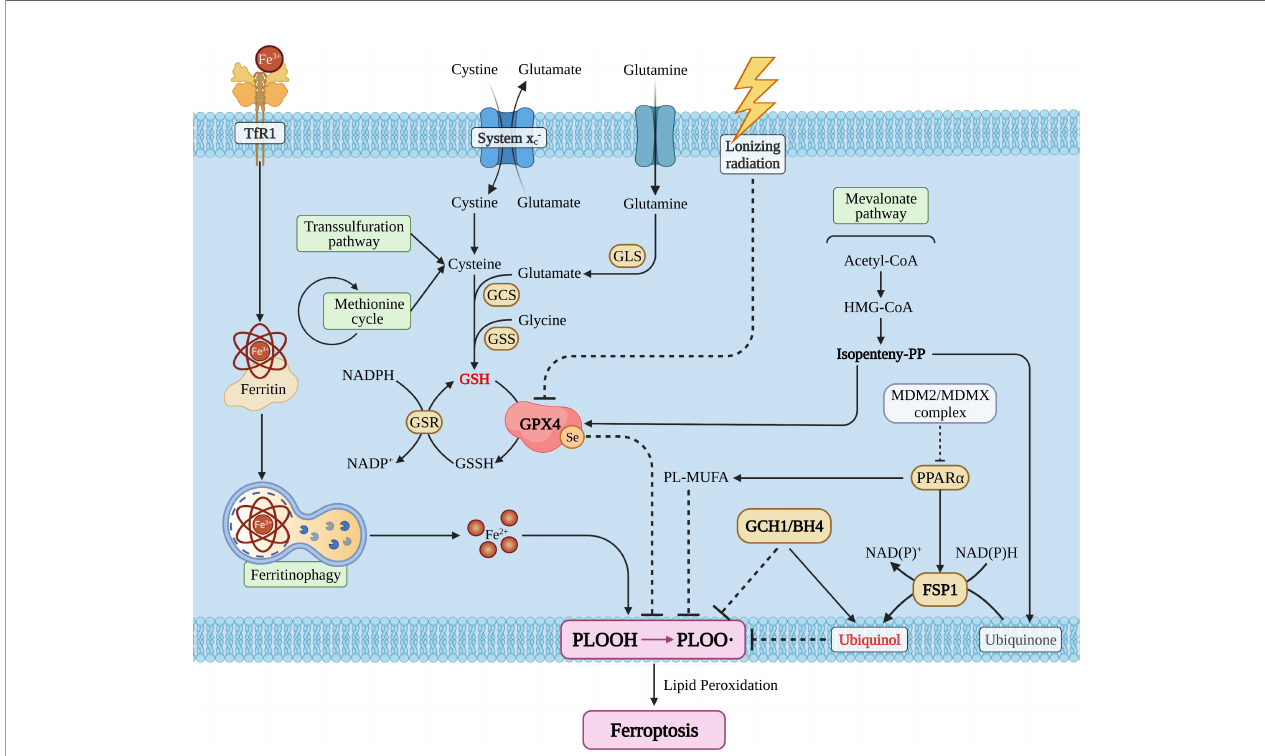
FIGURE 1 | The snapshot of ferroptosis pathways. TfR1, transferrin receptor 1; GLS, glutaminase; GCS, glutamylcysteine synthetase; GSS, glutathione synthetase; GSH/GSSH, glutathione; GSR, glutathione S-reductase; GPX4, glutathione peroxidase 4; MDM2, mouse double minute 2; MDMX, mouse double minute 4; PPAR a , peroxisome proliferator activated receptor alpha; FSP1, ferroptosis suppressor protein 1; GCH1, GTP cyclohydrolase 1; BH4, tetrahydrobiopterin; PL, phospholipid; MUFA, monounsaturated fatty